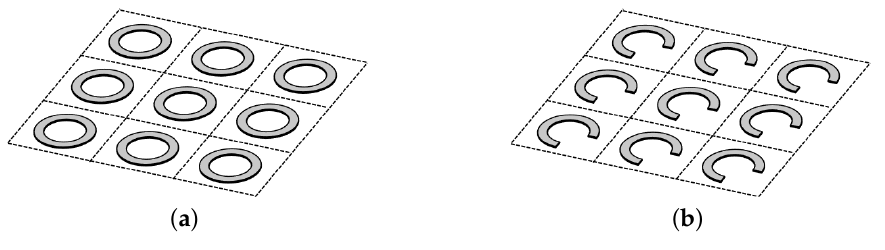
Figure 6. Electromagnetic surfaces which are ( a ) isotropic ( b )